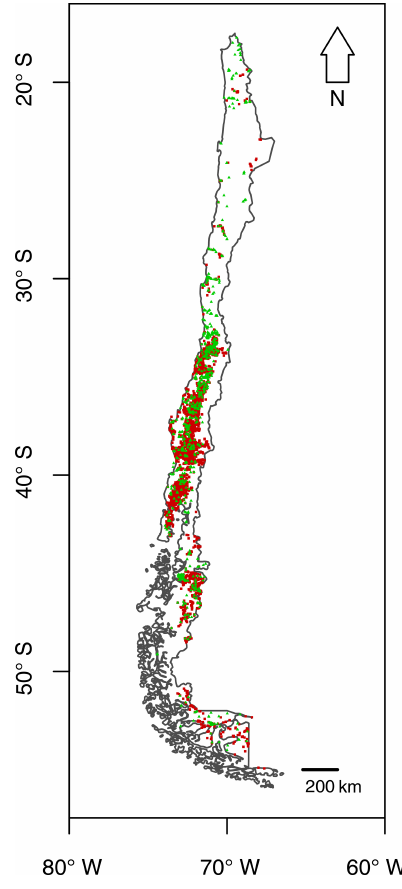
Figure 1. Spatial distribution of soil data points compiled in this work. Green triangles are soil profiles, and red squares are topsoil samples (up to 30cm).